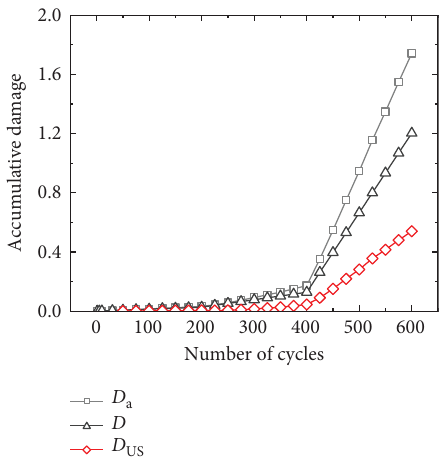
Figure 25: Damage index with number of